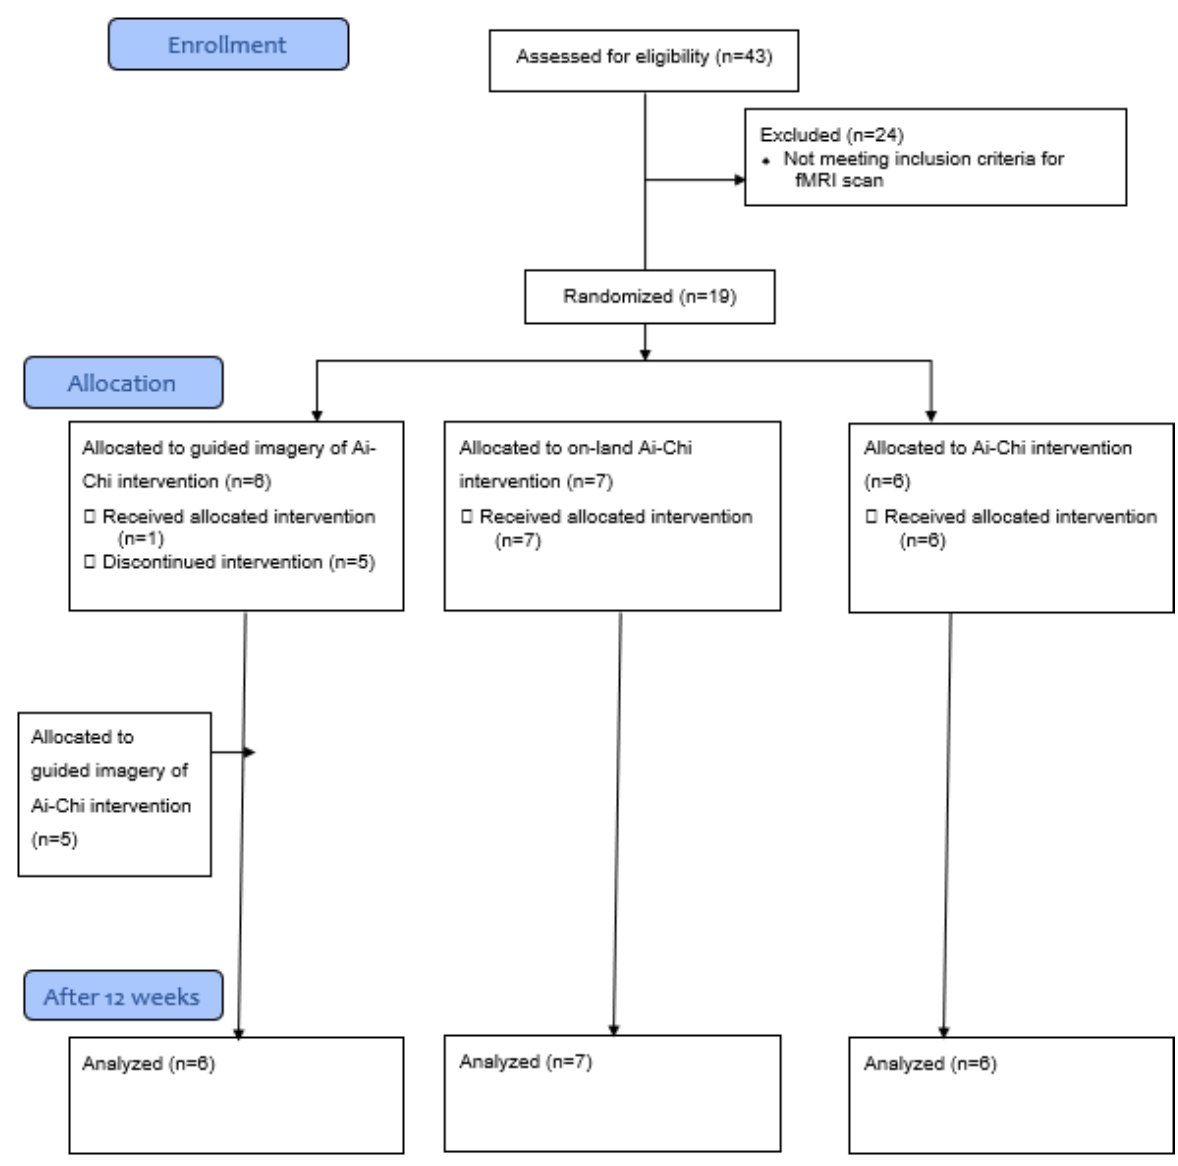
Figure 1. The CONSORT 2010 flow diagram.